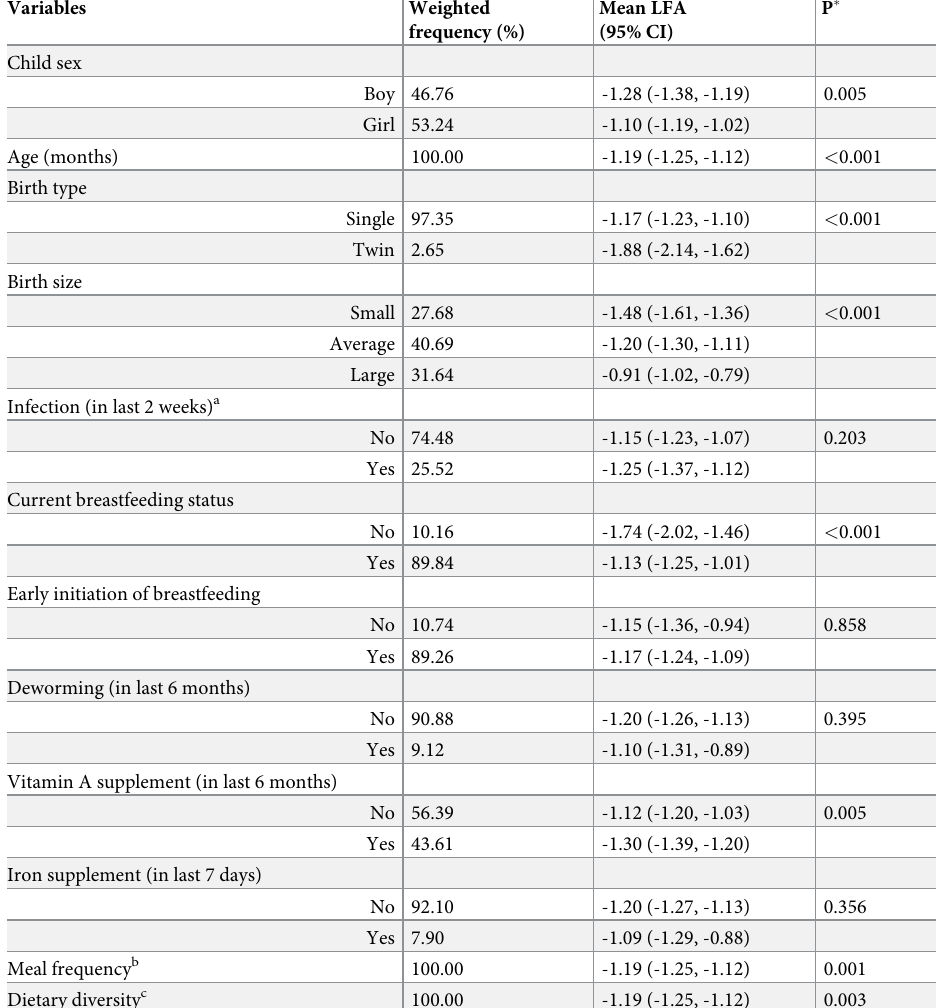
Table 2. Relation of proximal factors with length-for-age (N = 2,932).